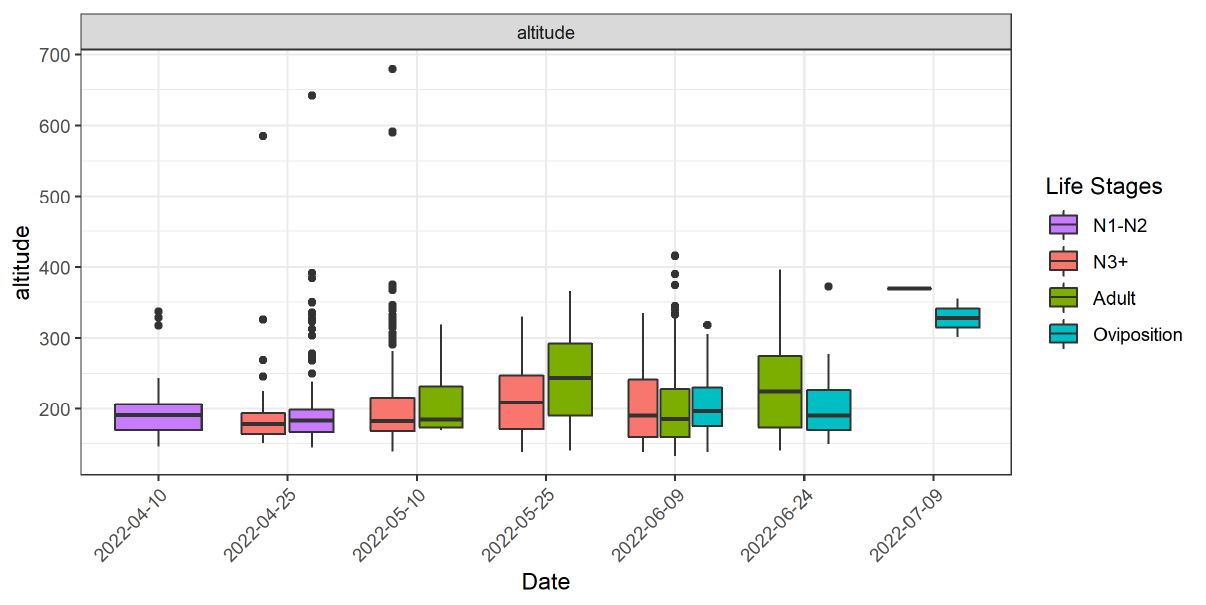
Figure 8. DEM at 30 m spatial resolution (source: Copernicus-DEM derived from Tandem-X DEM). Zoom areas for region of interest with majority of detected DMA locations.